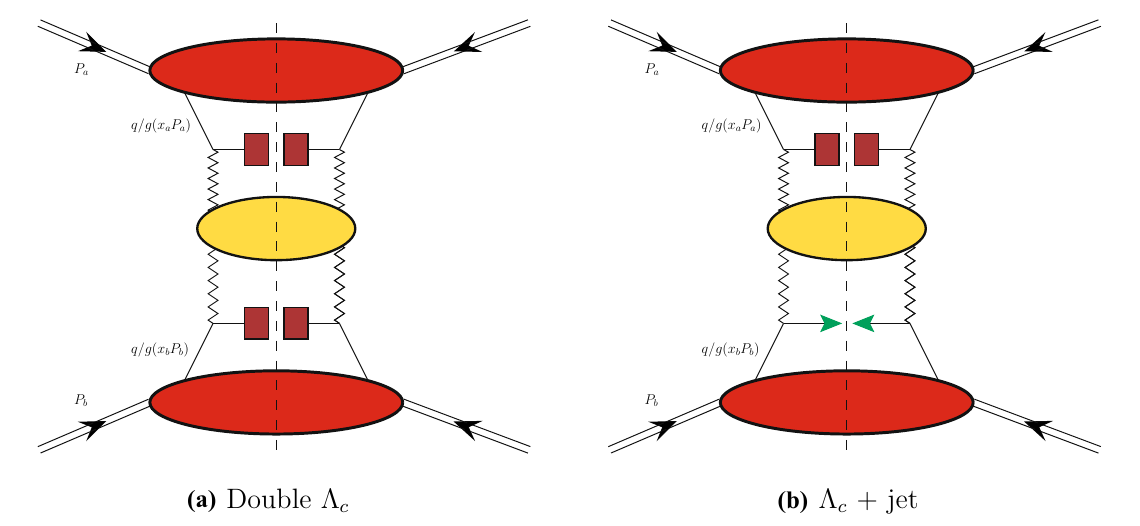
function. The BFKL gluon Green’s function, represented by the yellow central blob, is connected to impact factors through Reggeon (zigzag) lines. Diagrams were realized by making use of the JaxoDraw